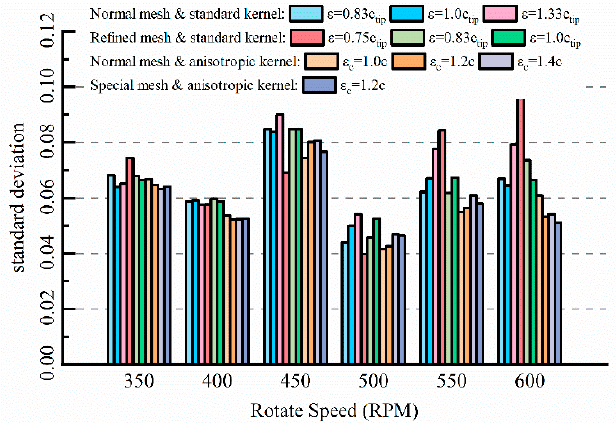
Figure 19. Standard deviation of the velocity magnitude in the plane along with the main flow.